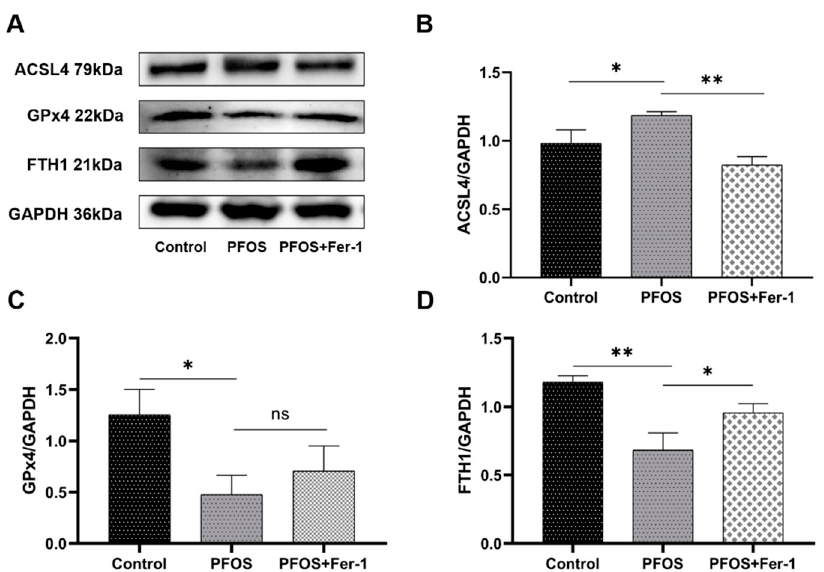
Figure 7. Expression of ACSL4, GPx4 and FTH1 in HK ‐ 2 cells exposed to PFOS or/and Fer ‐ 1. HK ‐ 2 cells were exposed to PFOS at 200 µ M for 12 h or/and cultured with Fer-1 at 1 µ M for 2 h prior to exposure to PFOS; the results were from three independent experiments. Data were expressed as